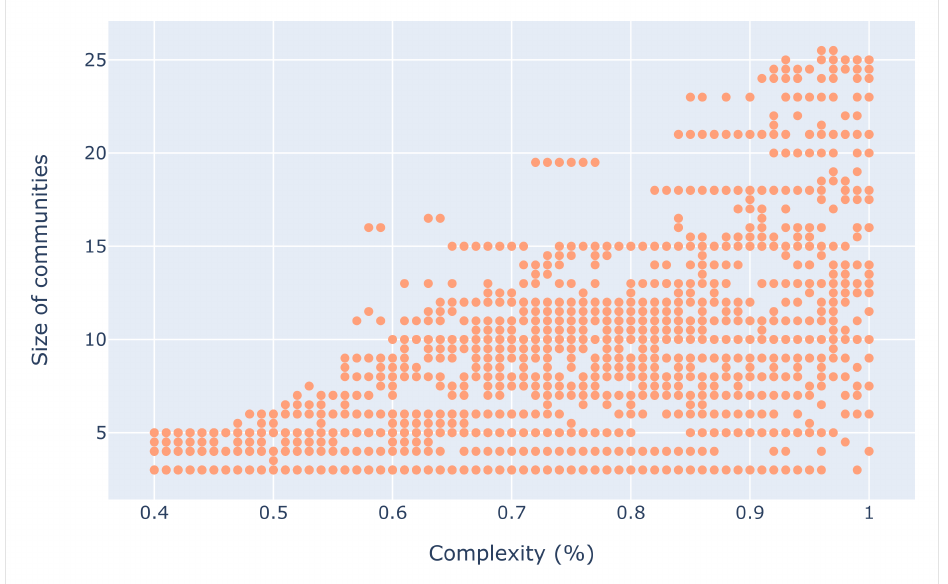
Figure 27. Size of communities for different complexity thresholds.